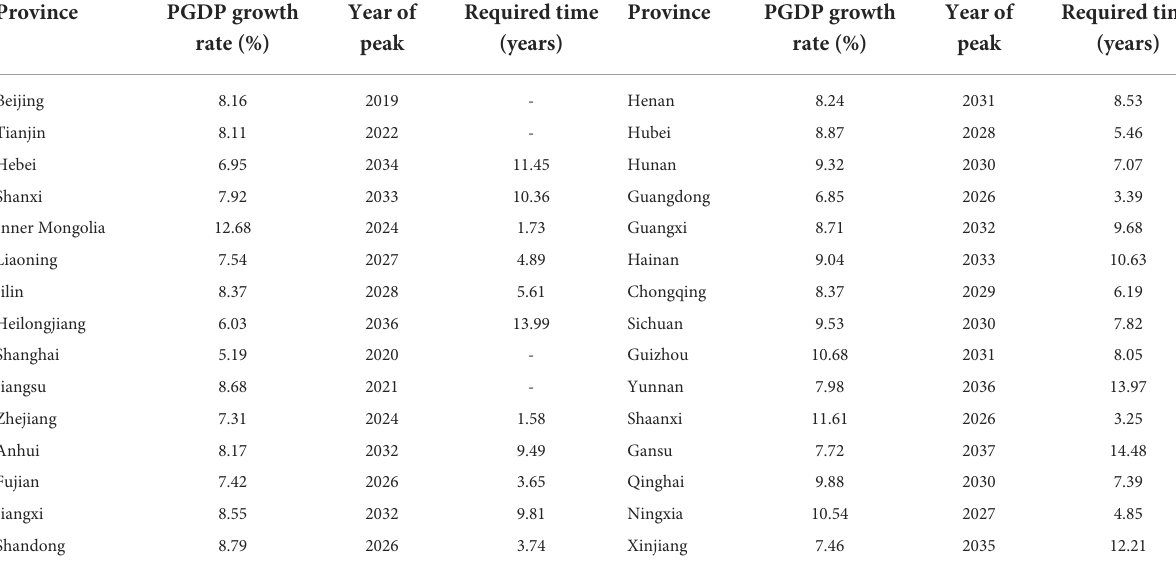
TABLE 6 Theoretical time for embodied carbon emissions in inter-regional trade to reach the peak in each province of China.